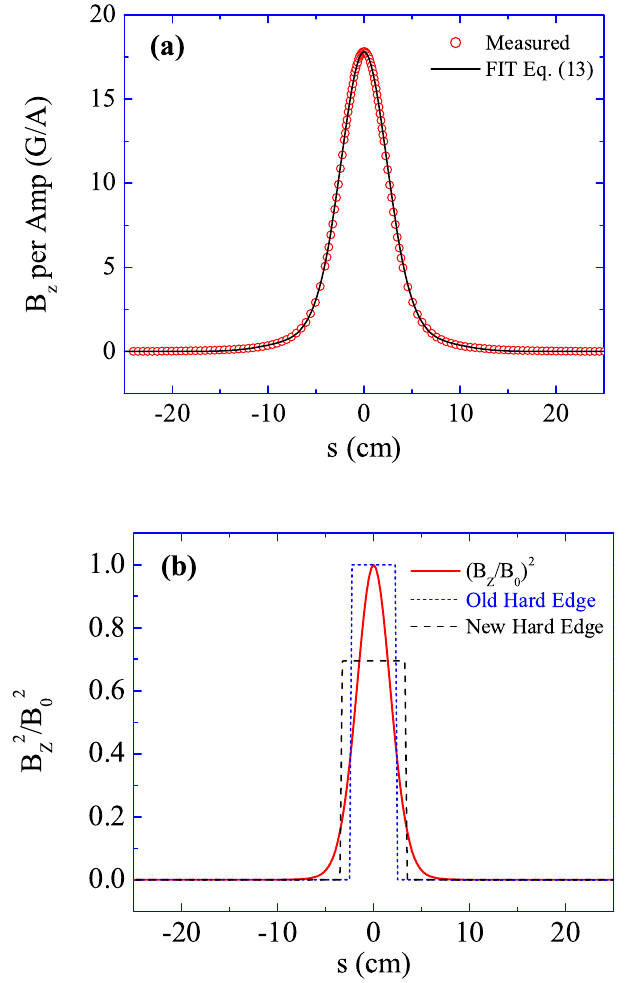
FIG. 4. (Color) Characterization of short solenoid in UMER matching section: (a) measured and analytical fit function profile, and (b) normalized solenoid [Eq. (13)] of on-axis B z strength and hard-edge